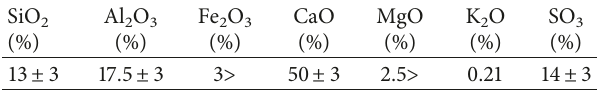
Table 1: Chemical compositions of rapid-hardening cement.